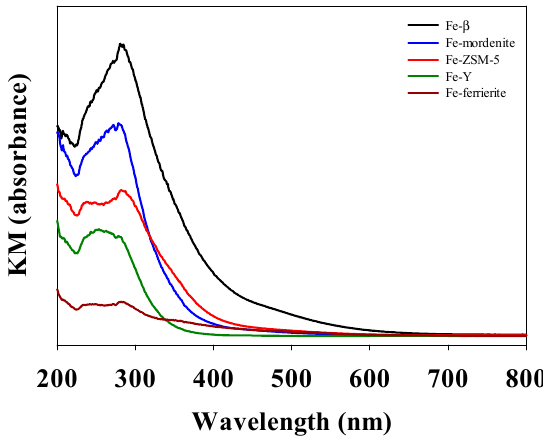
Figure 1. UV-Vis spectra of various Fe-zeolite catalysts prepared via an ion-exchange method.